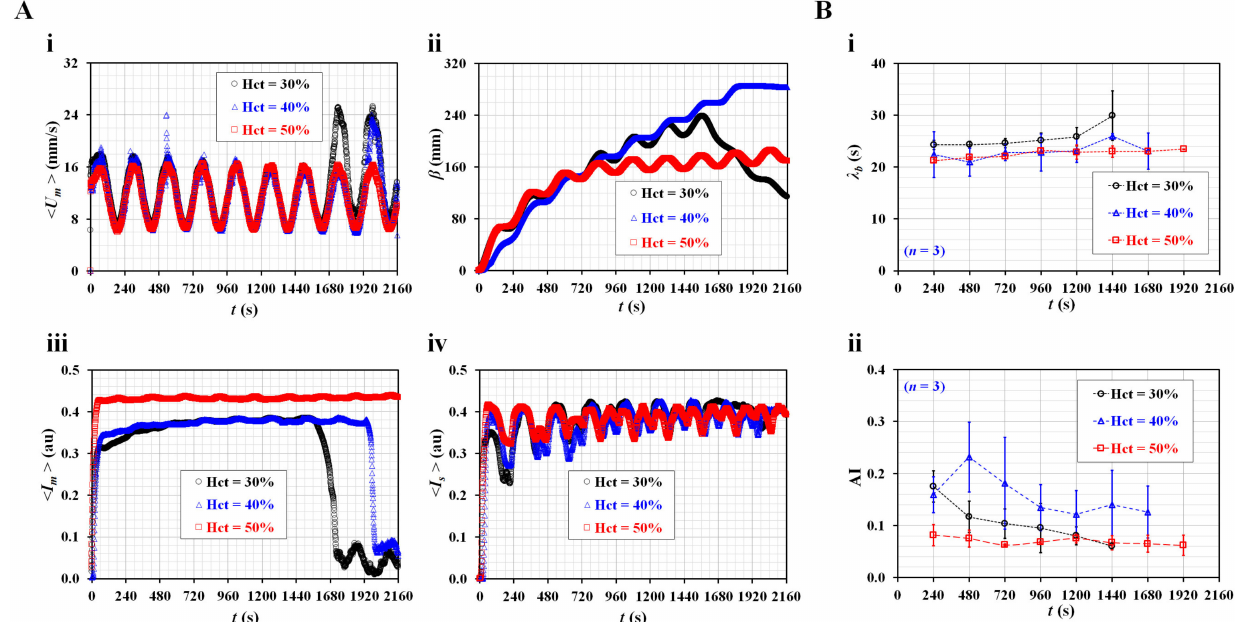
Figure 5. Contribution of hematocrit to rheological properties in pulsatile blood flow. ( A ) Quan- tification of four parameters (i.e., < U m >, β , < I m >, and < I s >) with respect to Hct = 30, 40, and 50%. Temporal variations of ( i ) < U m >, ( ii ) β , ( iii ) < I m >, and ( iv ) < I s > were obtained with respect to